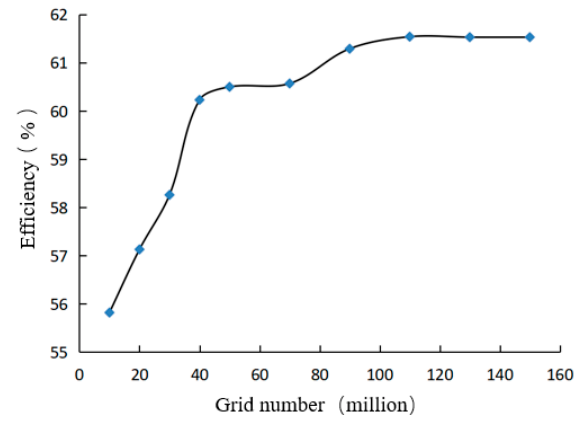
Figure 5. Grid Figure 5. Grid independence. Table 1. The number of grids and nodes in each computing part.